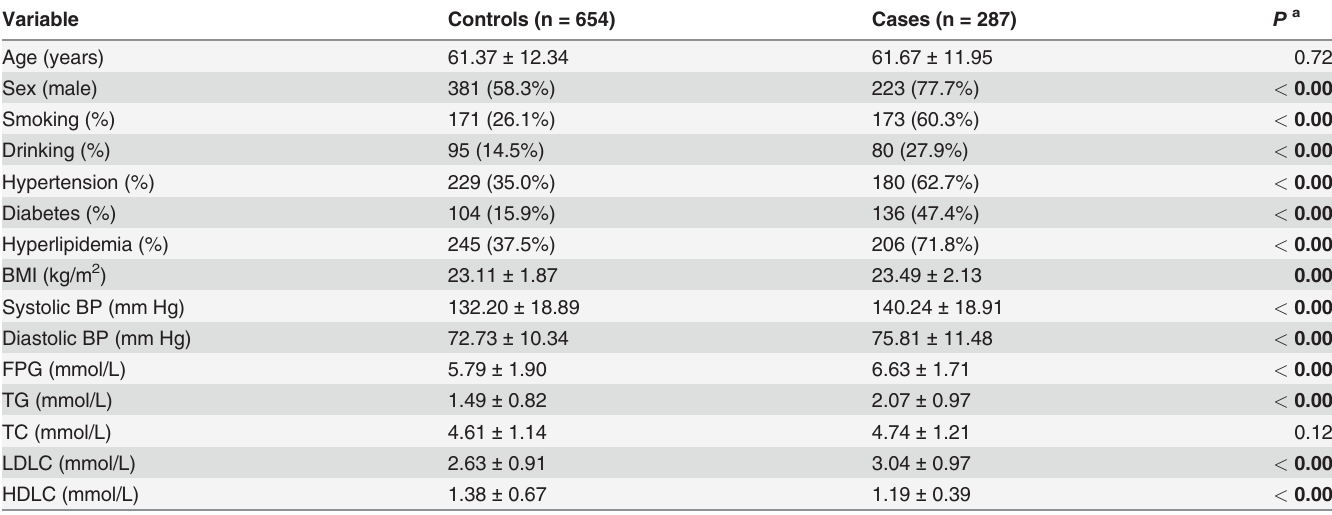
Table 1. The characteristics of MI cases and